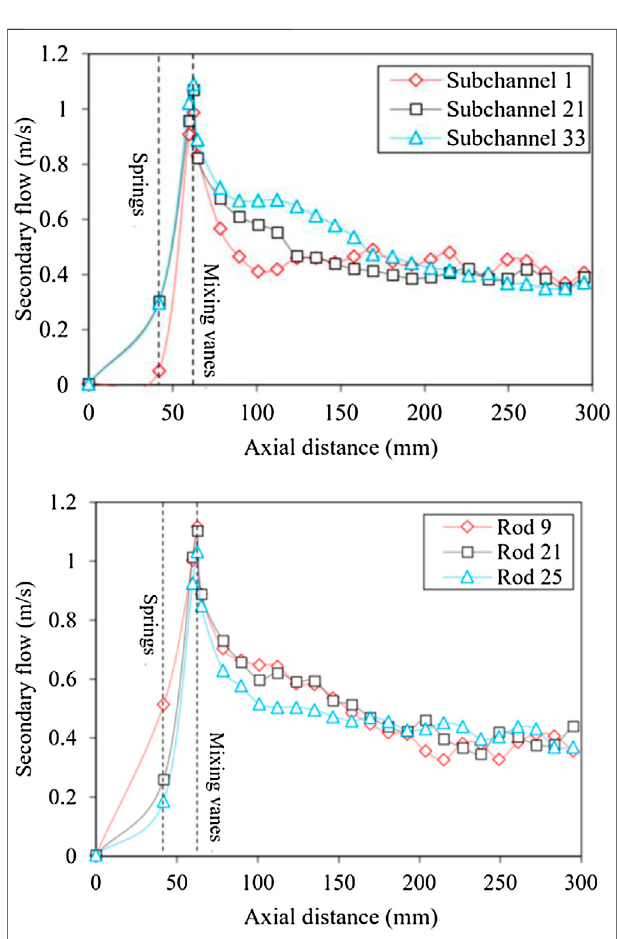
FIGURE 5 | Distribution of secondary fl ow along axial direction in the sub-channel and around the fuel rod.